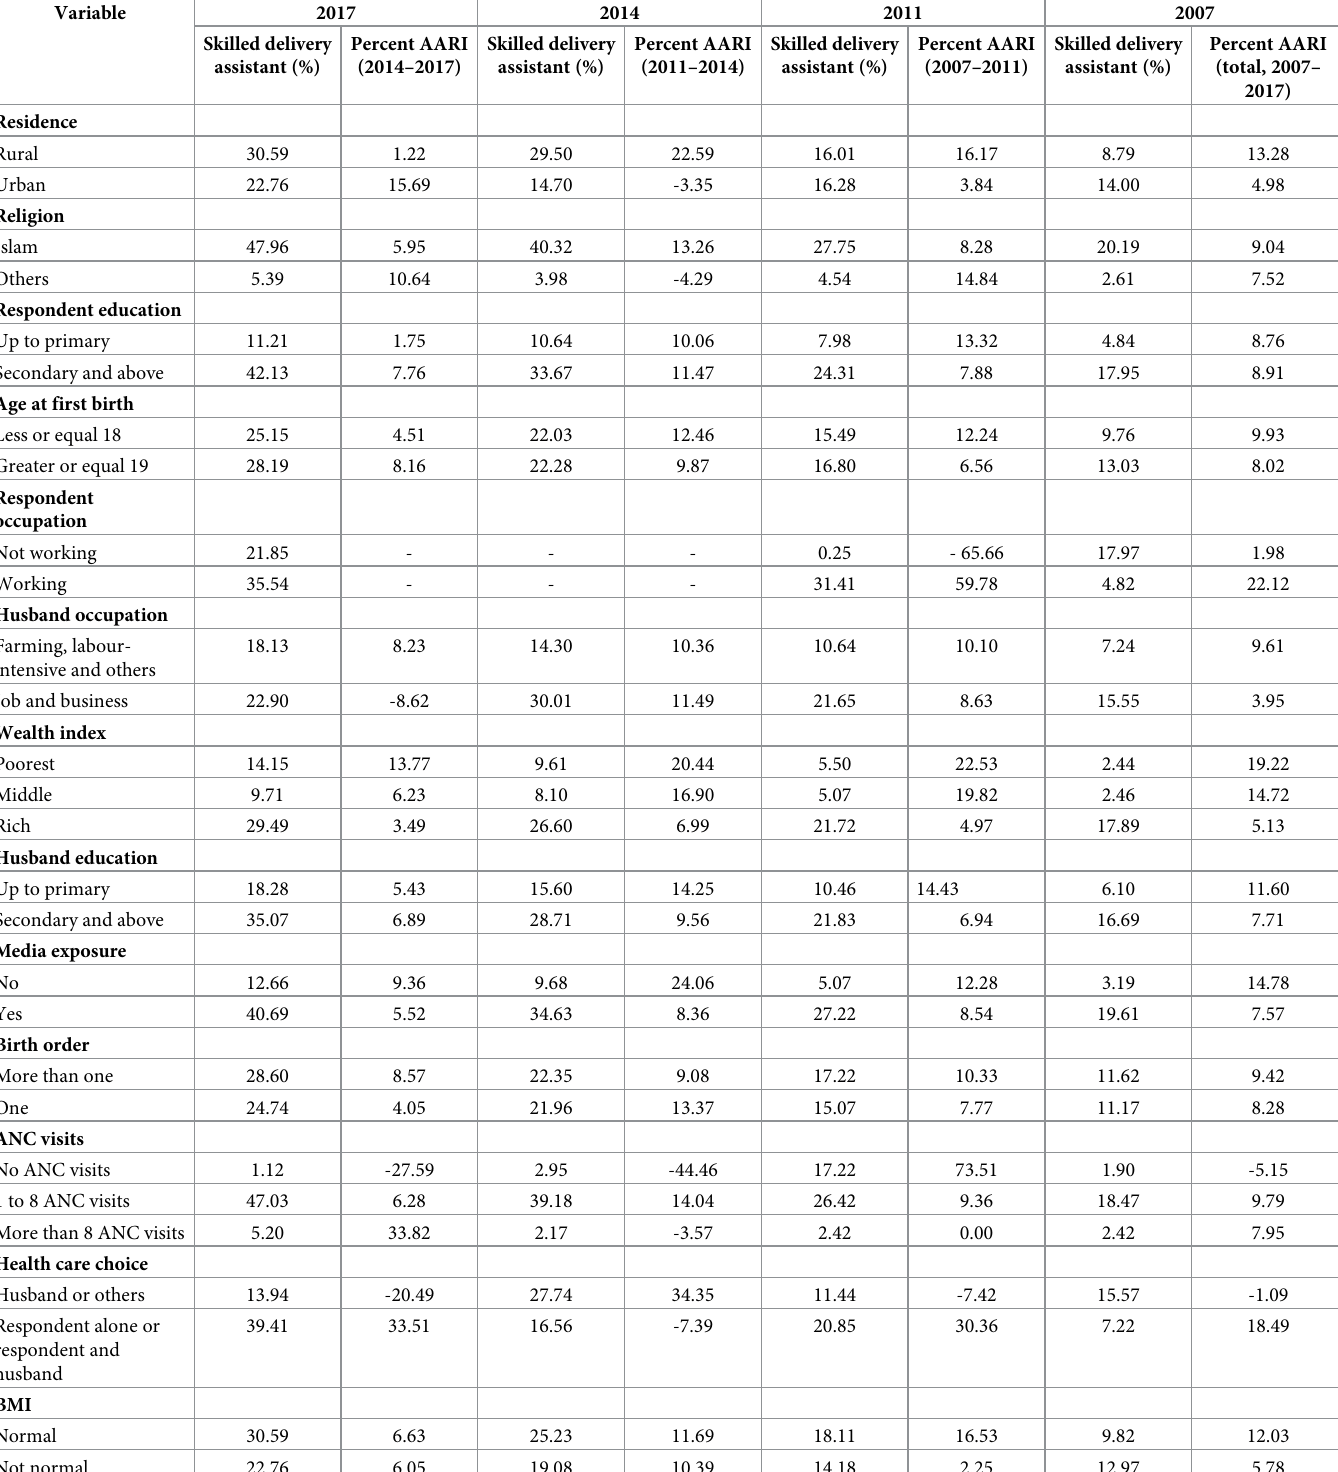
Table 3. The average annual rate of increase in the utilization of SBAs during delivery in Bangladesh, according to background characteristics in the 2007 to 2017– 2018 BDHS data.